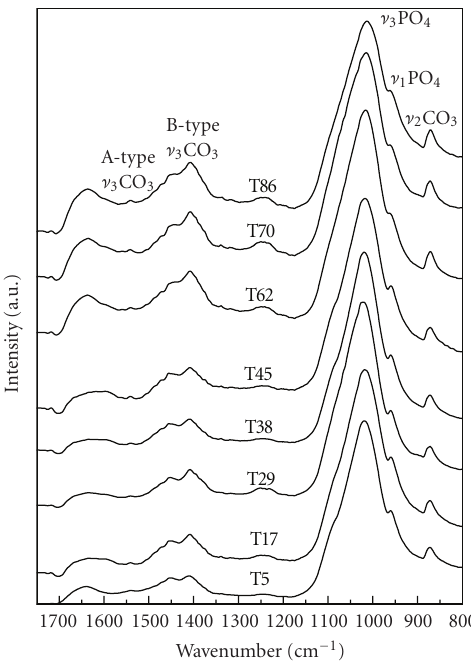
Figure 8: The 1750–800 cm − 1 region of FTIR spectra of the human dental apatite measured from samples of 5 to 86 years old.